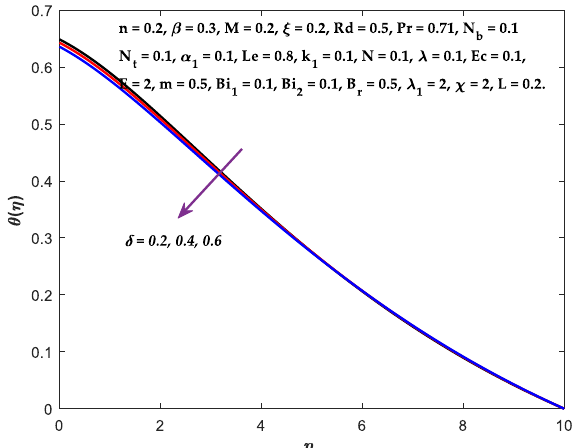
Figure 16. Diagram of δ v/s θ(η) .